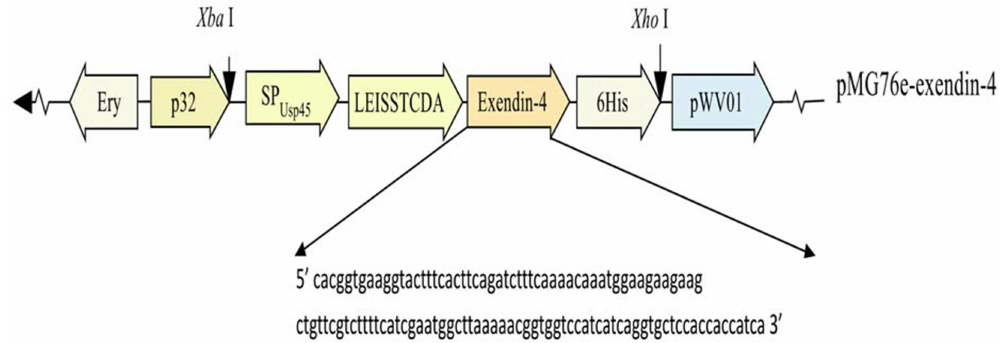
Fig 1. Expression cassettefor recombinant exendin-4 secretion by L . paracasei strain L14. Expression of the recombinant exendin-4 was controlledby the constitutive p32 promoter. SP Usp45 : sequenceencodingthe signal peptide Usp45; LEISSTCDA: sequenceencodingthe synthetic LEISSTCDA propeptide; the codon- optimizedcDNA sequence of exendin-4 is also